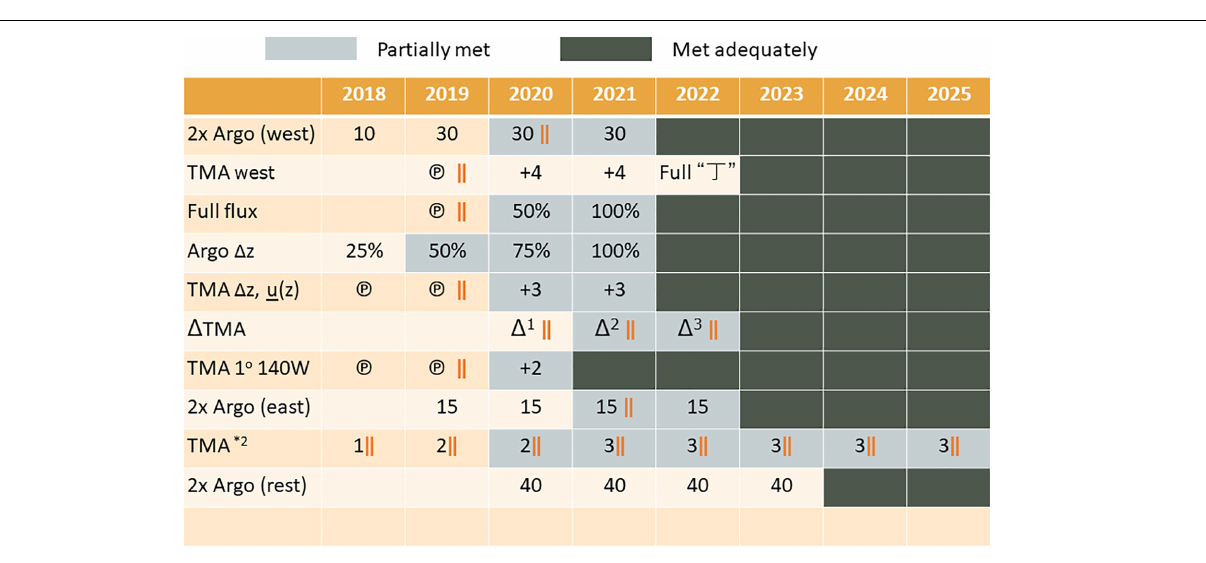
FIGURE 9 | Schematic providing detail of the schedule for change in the Backbone involving Argo, the TMA, and so-called super-sites (here denoted by TMA ∗ 2 ). (cid:13) The symbol P denotes a pilot mode. The symbol | | refers to review/evaluate points. For Argo the numbers show the annual seeding rate. For the TMA the numbers usually refer to enhancement levels. In anticipation of changes to the TMA (denoted by (cid:49) TMA), we assume three phases (cid:49) 1 , (cid:49) 2 , and (cid:49) 3 , following the priorities outlined in Section “The TPOS 2020 First Report.” The shading indicates the degree to which requirements will be met through this schedule (approximate) except for the supersites. “TMA west” currently consists of the TAO line at 165 ◦ E and 3 JAMSTEC sites. The former State Oceanic Administration have outlined plans to develop the so-called “ding” array (denoted by “ ”) which extends the TMA to the northwest while at the same time supporting some of the key equatorial sites of the TMA (Chen et al.,